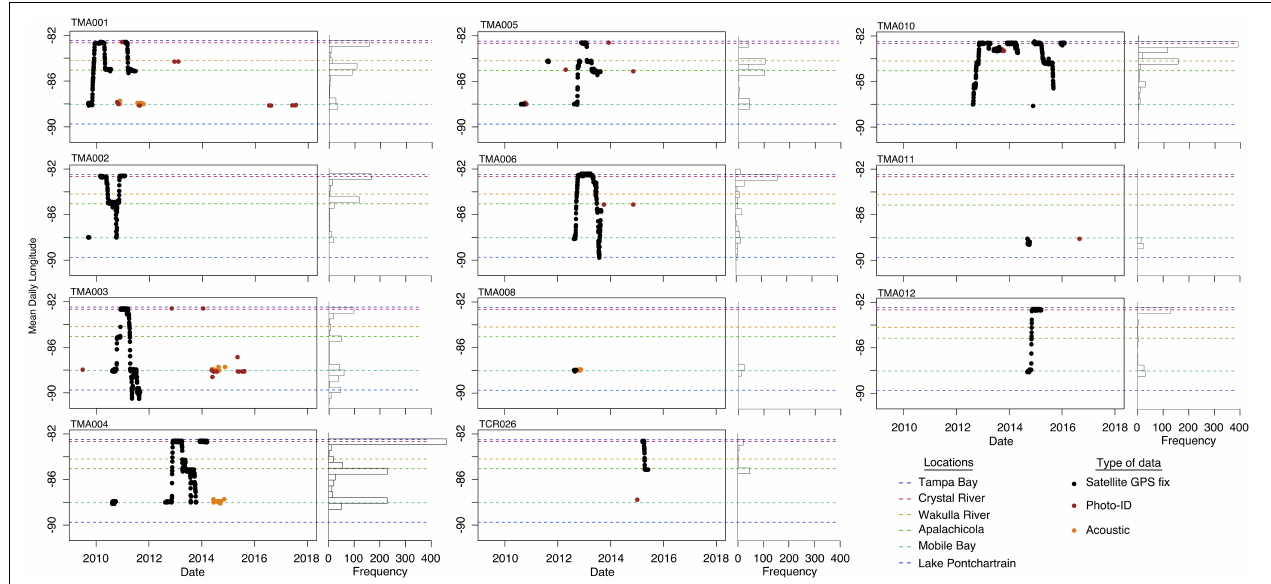
FIGURE 2 | Mean daily longitudes through time and total frequency of longitudes for individual manatees during migrations from 2009 to 2018. Location data include satellite tag detections, passive acoustic monitoring, and photo-identification of individuals with known scar patterns.